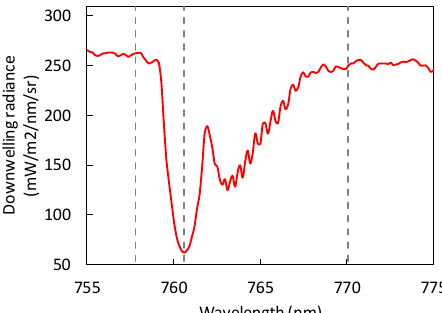
Figure 4. Illustration of the bands used in 3FLD method for solar-induced chlorophyll fluorescence (SIF) retrieval in this study. The vertical dash lines shows the spectral position of the bands at the left of, inside, and at the right of the O2-A absorption feature.